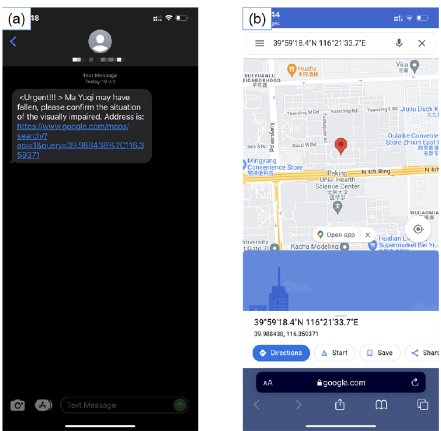
Figure 15. Screen of visually impaired user fall information received by emergency contacts. ( a )